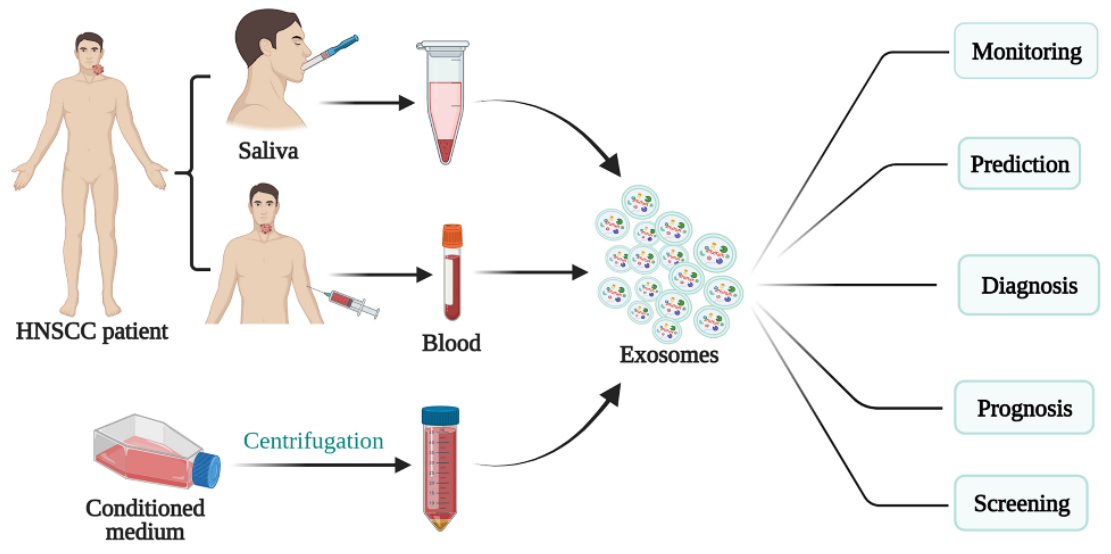
Figure 2. Schematic presentation of the use of exosomes for HNSCC diagnosis, prognosis, and treatment.